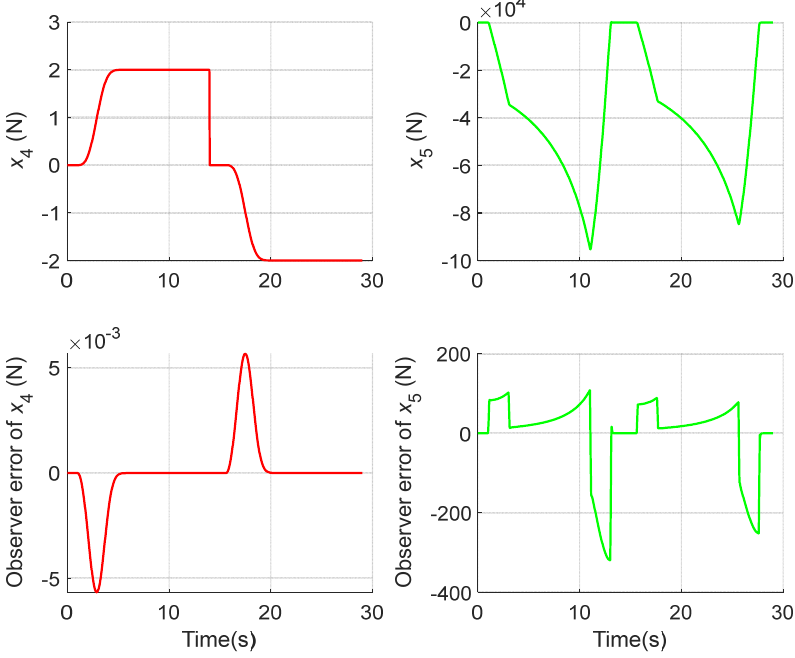
ˆ e ˆ e , for 4 5